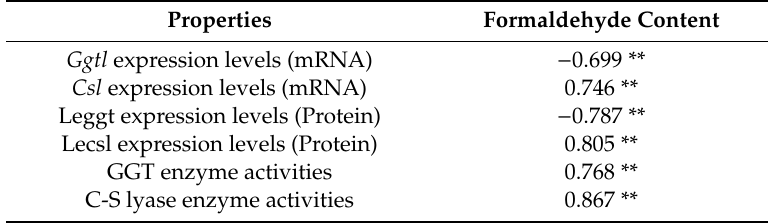
Table 1. Correlations (R) of the formaldehyde contents in L. edodes with Ggtl expression levels, Csl expression levels, Leggt expression levels, Lecsl expression levels, GGT enzyme activities and C-S lyase enzyme activities at di ff erent growth